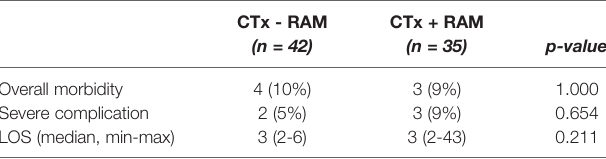
TABLE 5 | Effect of ramucirumab (RAM) addition to pre-PIPAC chemotherapy (CTx) on postoperative complication rates and length of stay (LOS). CTx -